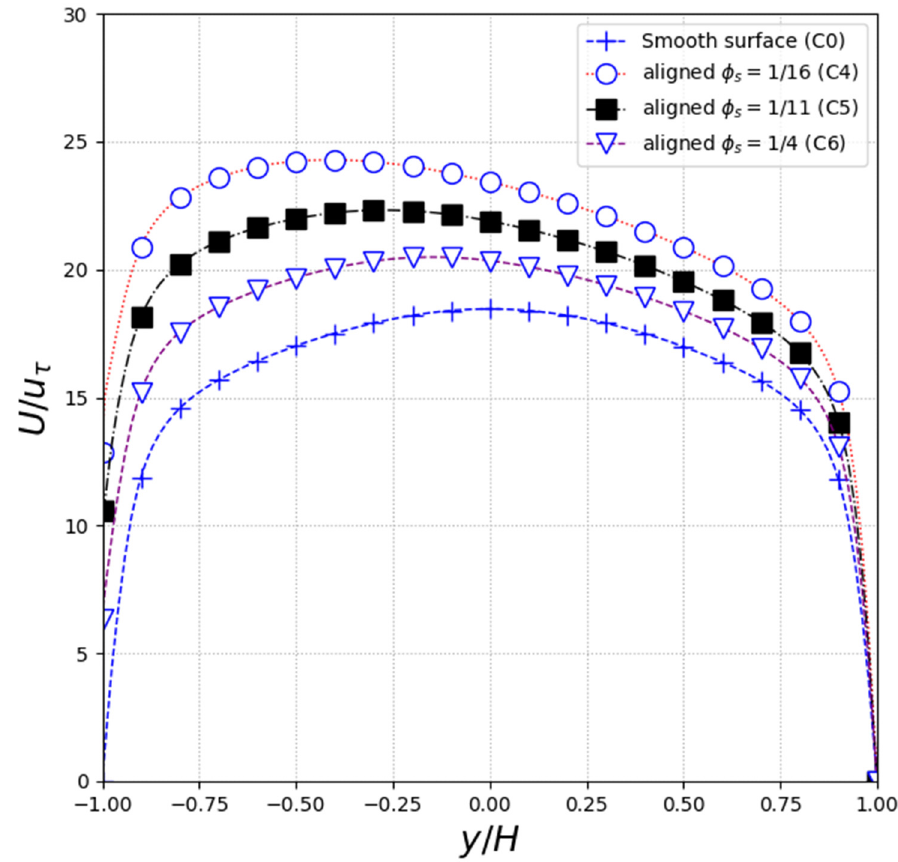
Table 4. The bulk velocity in the SHS region increases as the solid fraction decreases (which means that the portion of the interface between the liquid and gas increases). Additionally, this increase in the SHS region affects the velocity profile in the smooth wall region, which also increases. The bulk velocity at the condition of φ s = 1 smooth wall. As the solid fraction increases to φ s = 1 velocity decreased to 32% and 17%, respectively. When the decrease in the solid fraction increased the drag reduction, the total mass flux increased with a decrease in the solid fraction, and then, the drag reduction induced an increase in the mass flux in the channel with SHS.